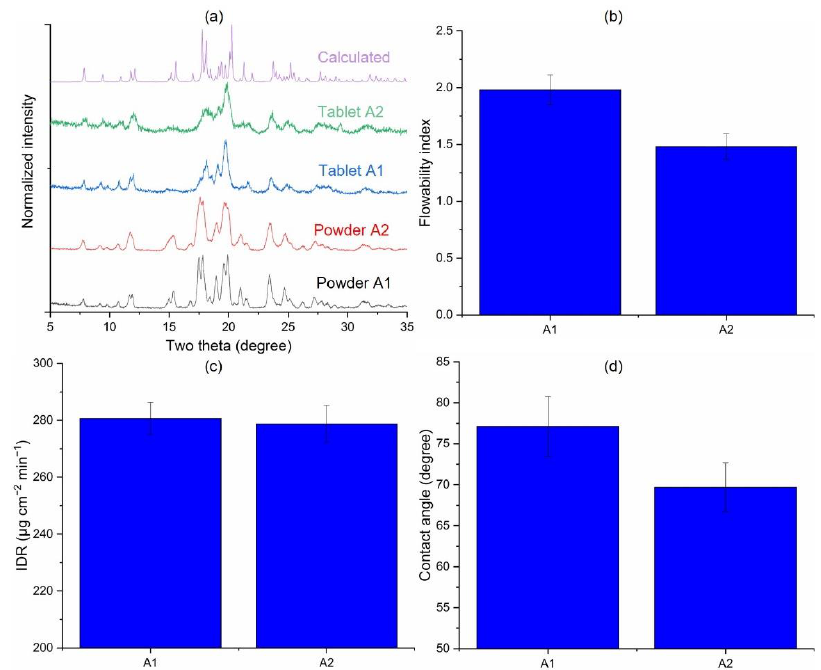
Figure 3. Solid-state characterization, bulk properties of Samples A1 and A2. ( a ) X-ray diffraction; ( b ) flowability ( c ) intrinsic dissolution rate; ( d ) contact angle.